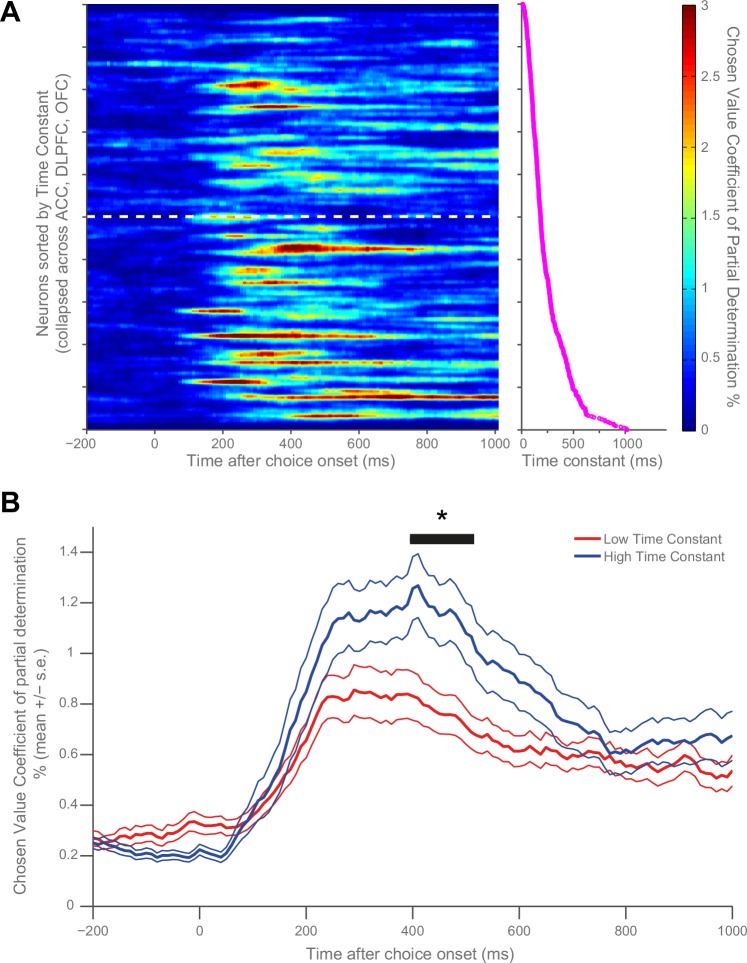
Resting time constant predicts chosen value correlates during decision phase.(A) Strong chosen value correlates were more prevalent in neurons with higher time constants. Coefficient of partial determination (CPD) for chosen value across time for each PFC neuron (n = 446) was stacked into a matrix. The rows of the matrix (i.e. each individual neuron) were sorted by increasing time constant, and then convolved with a Gaussian function (see Materials and methods). The white dashed line indicates a median split by time constant; high time constant neurons are beneath the line, low time constant neurons are above. The graph to the right of this matrix shows the individual decay time constant for each neuron (row) in the matrix. (B) When all neurons are subdivided by a median split of time constant, those with a higher time constant exhibit stronger chosen value correlates. Black trace indicates a significant cluster of bins, corrected for multiple comparisons across time (see Materials and methods, p=0.0298). CPD (mean ± SE) for chosen value was calculated by multiple linear regression analysis (see Materials and methods). Figure 3—figure supplement 1 shows a rank correlation of resting time constant with chosen value coding across time.